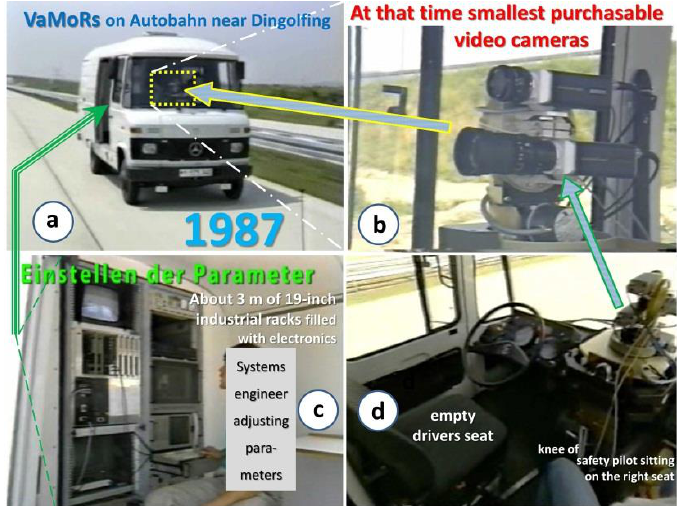
Figure 3. The first high-speed autonomous vehicle, VaMoRs, from 1986 to 2004 with three generations of vision systems [21] (sub-images from video ‘VaMoRs Autobahn Dingolfing 1987′).